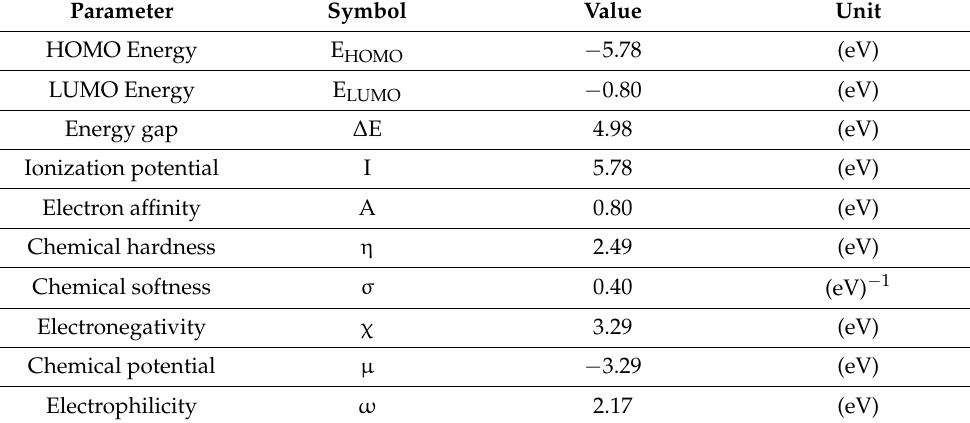
Table 1. The calculated HOMO, LUMO energies and their corresponding quantum chemical parameters.